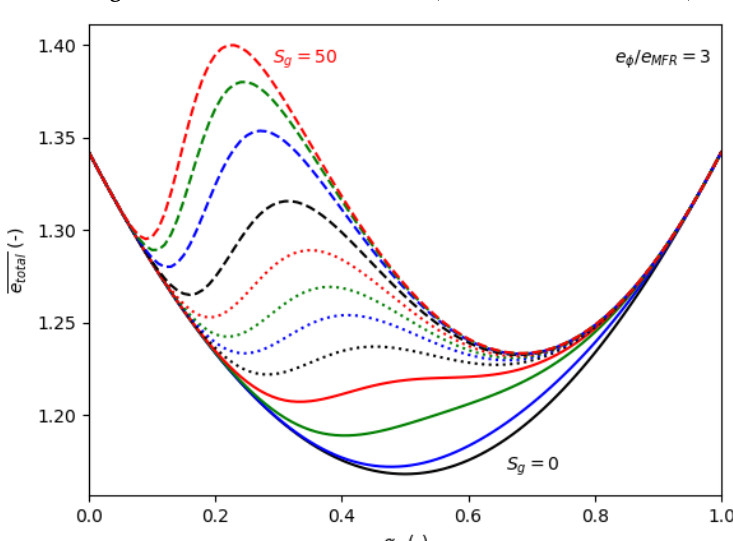
Figure A1. Normalized total error (oxidizer rich combustion).